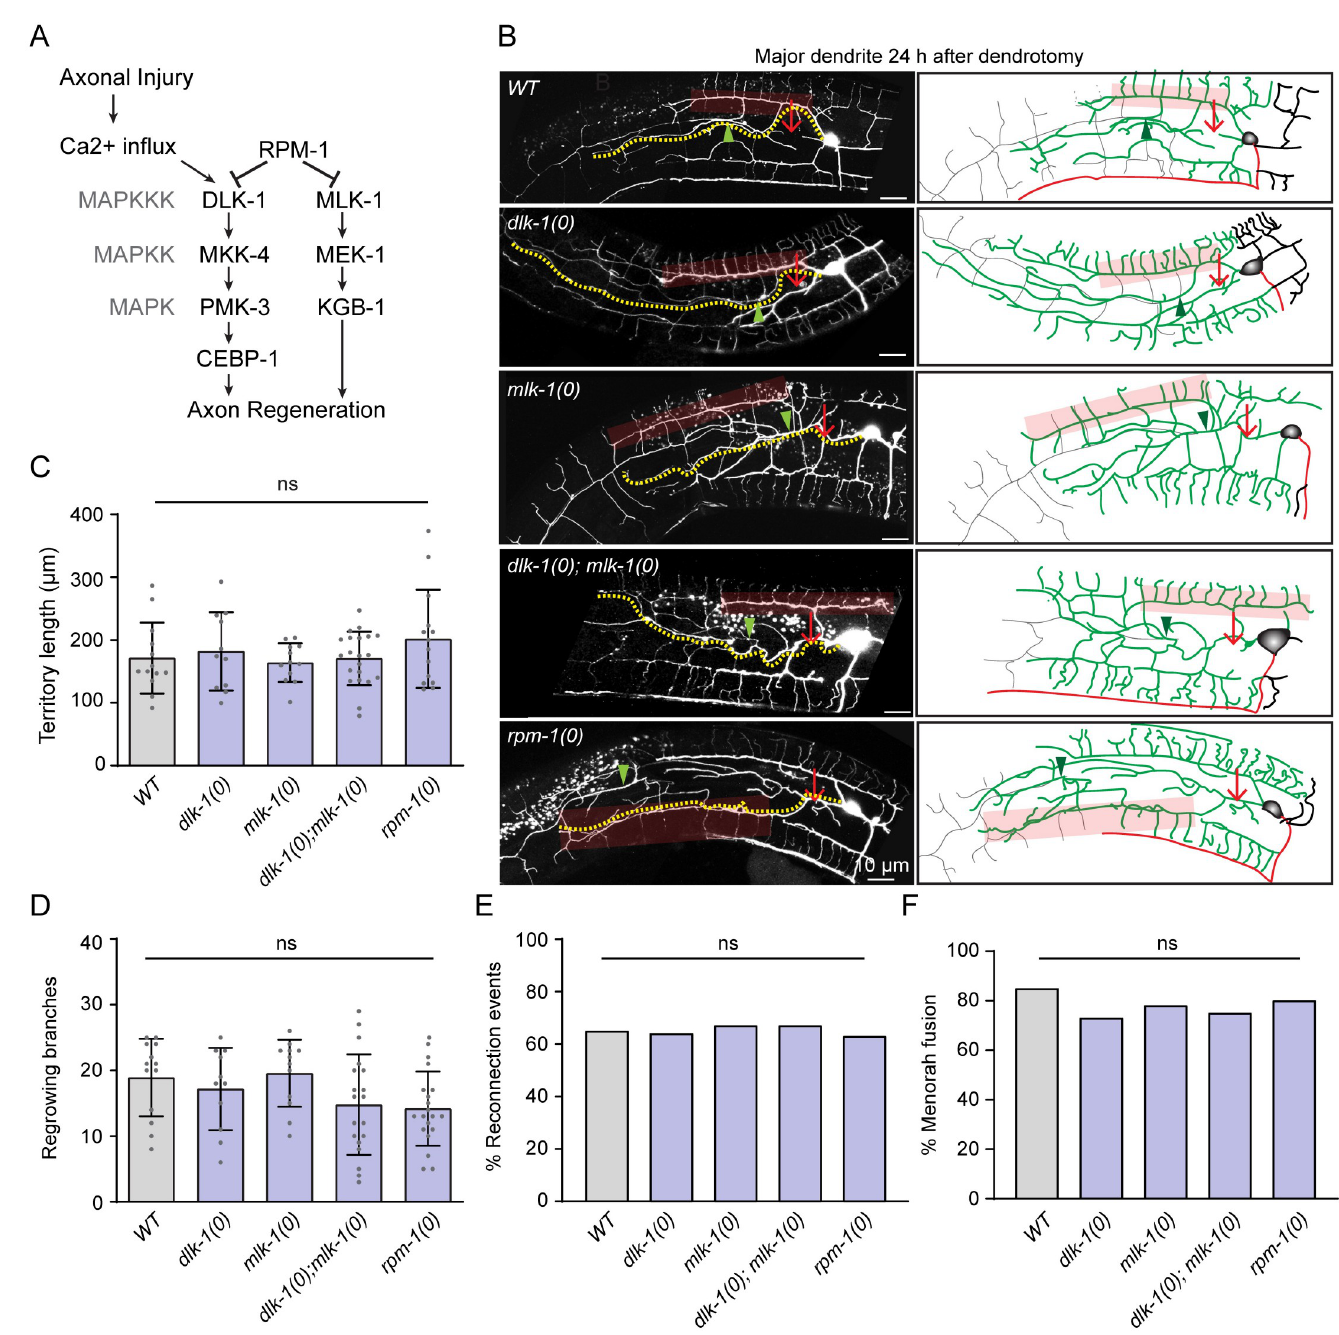
Fig 2. The dendrite regeneration is independent of DLK/MLK pathways. (A) Signaling pathway involving DLK-1 MAP kinase responsible for the initiation of axonal regeneration following Axotomy. (B) Confocal images of the regeneration events of primary major dendrites in the wild type, dlk-1(0) , mlk-1(0) , dlk-1(0); mlk-1(0) and rpm-1(0) at 24h post-dendrotomy. The experiment was done in the in wdIs52 ( pF49H12 . 4 :: GFP )reporter background. The illustrations on the right indicating site of dendrotomy (red arrow), regenerating dendrites (green color), distal part (grey color), territory length (yellow dotted lines), reconnection events (green arrowheads) and menorah-menorah fusion (faded red boxes). (C-F) Quantification of the territory length (C), total number of branches (D), the percentage of reconnection events (E), and the percentage of menorah-menorah fusion events (F) in the wildtype, dlk-1(0) , mlk-1(0) , dlk-1(0);mlk-1(0) , and rpm-1(0) at 24h post-dendrotomy. N = 3–5 independent replicates, n (number of regrowth events) = 15–20. Statistics, for C-D, One-way ANOVA with Tukey’s multiple comparison test, p < 0.05 � , 0.01 �� , 0.001 ��� and for E-F, Fisher’s exact, p < 0.05 � , 0.01 �� , 0.001 ��� . Error bars represent SD. ns, not significant.